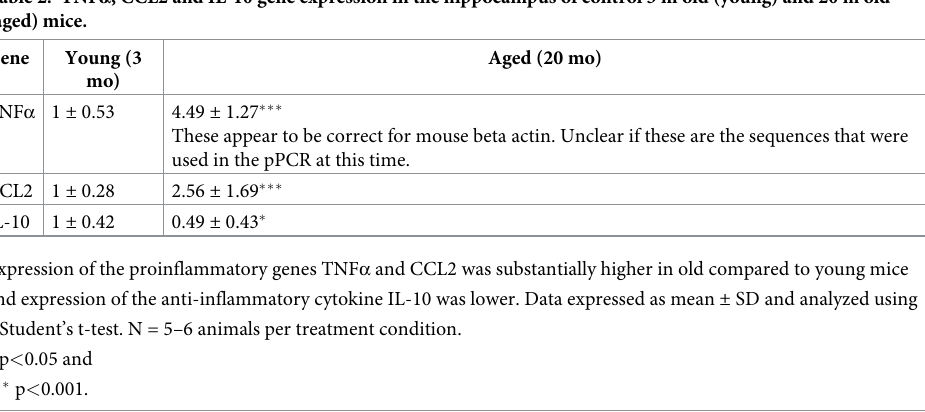
Table 2. TNF α , CCL2 and IL-10 gene expression in the hippocampus of control 3 m old (young) and 20 m old (aged) mice. Gene Young (3 mo) TNF α 1 ± 0.53